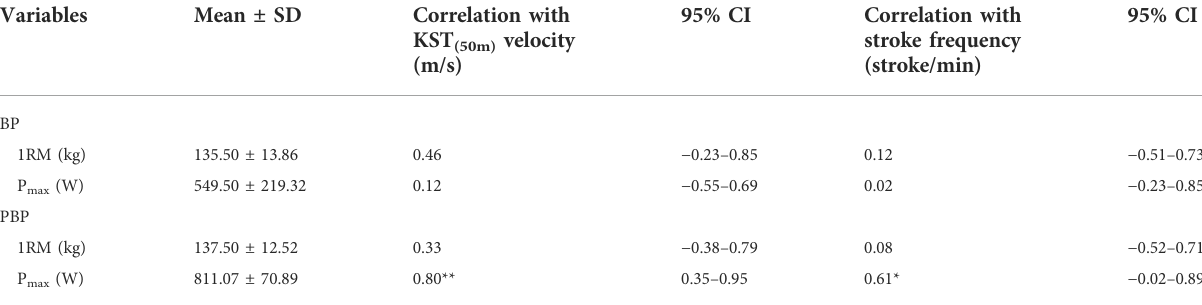
TABLE 2 Dynamic parameters (1 RM and P max obtained for each athlete) expressed at PBP and BP in correlation with kinematic parameters observed on KTS. All values are mean ± SD. Correlation (95% Con fi dence Interval) is reported p < 0.05 (*) and p < 0.01 (**). Variables